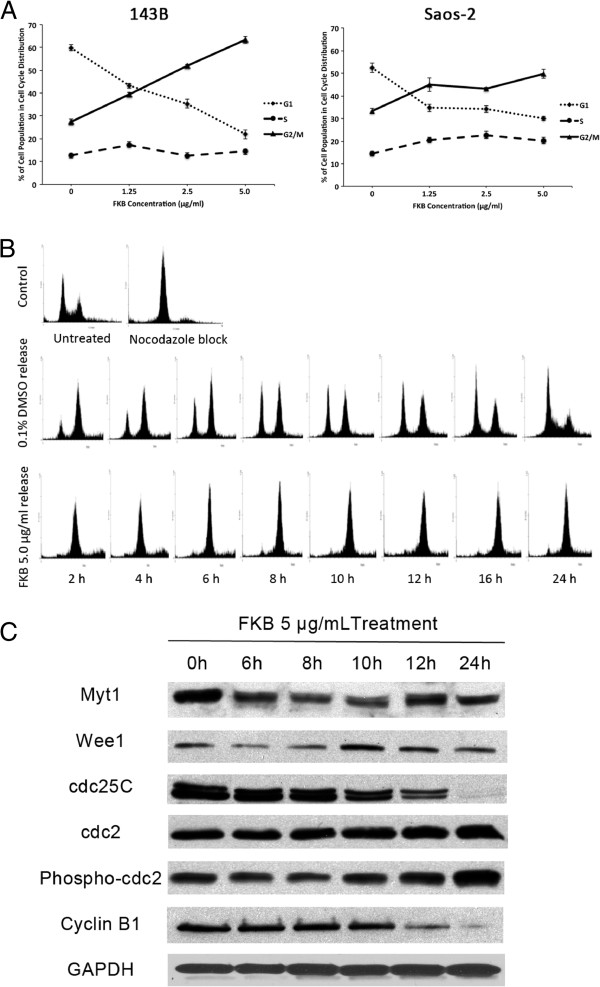
FKB induced G2/M arrest in OS cells. A, 143B and Saos-2 cells were treated with vehicle control or FKB at different concentrations for 24 h and analyzed for cell cycle. Percentage of cell cycle distribution after FKB treatment was presented. Points, mean of three samples for each concentration; bars, SE. B, 143B cells were blocked at G2/M phase and released form the block into either control or 5 μg/ml FKB. At times indicated, cells were collected, fixed, and analyzed by flow cytometry. C, The effect of FKB (5 μg/ml) on cell-cycle regulatory markers was examined by Western blot analysis. The protein extracted from 143B cells treated with FKB for indicated time was resolved by SDS-PAGE.